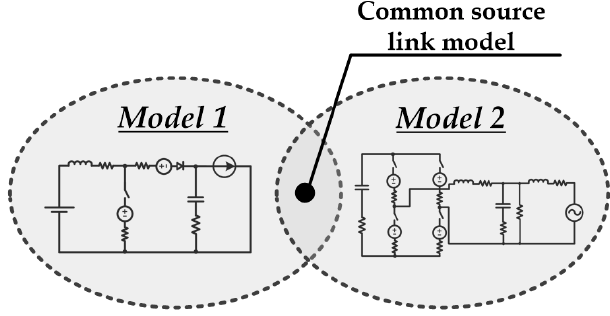
Figure 4. Multi-stage converter model with single matrix form.